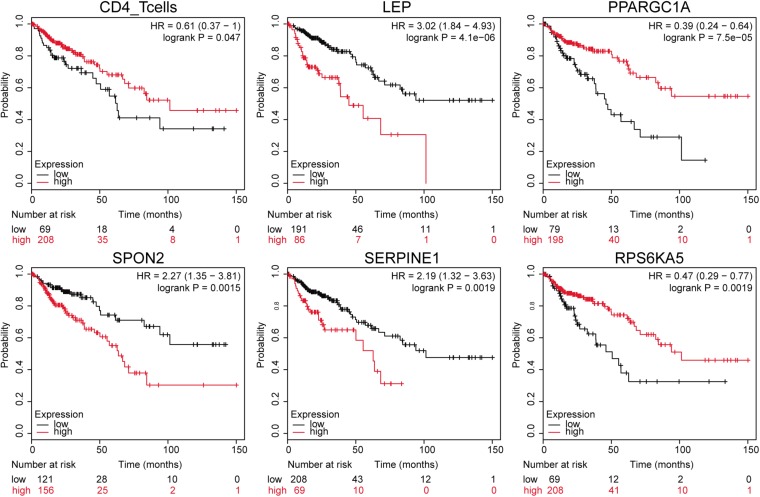
Gene expression-related survival curve. The black and red curves represent the low- and the high-expression groups, respectively.